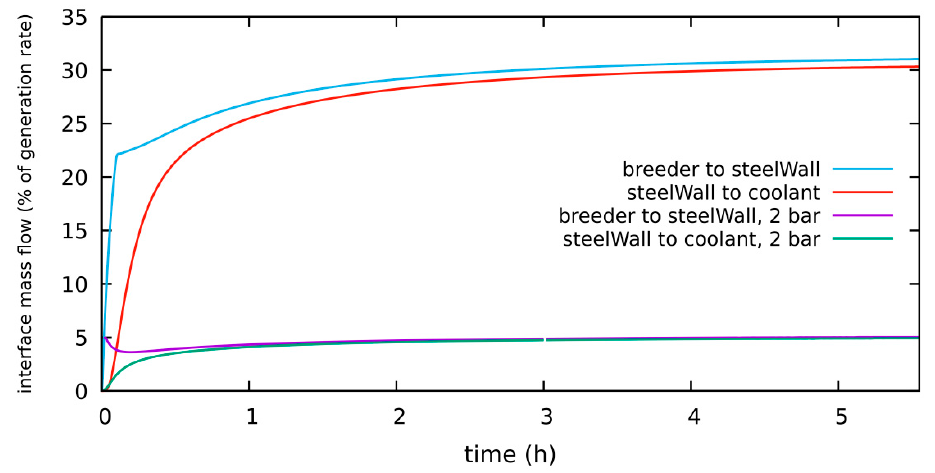
Figure 14. Transient tritium flow through patch interfaces breeder to and from steel, and steel to and from coolant for 2-bar vs. 80-bar purge gas pressure at equal mass flow.